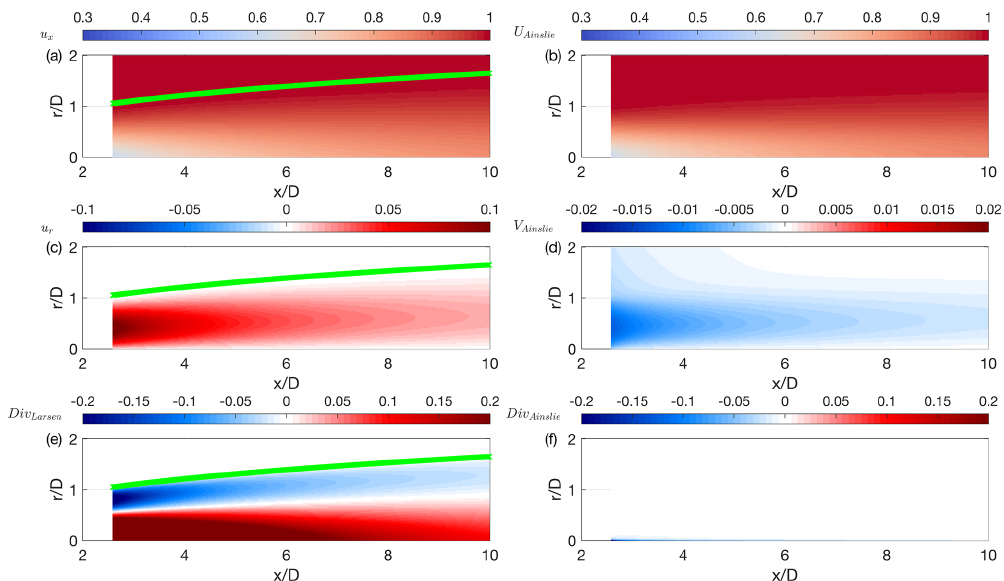
Figure B1. Assessment of the Larsen wake model (a, c, e) against the Ainslie wake model (b, d, f) : (a–b) streamwise velocity, (c–d) radial velocity, (e–f) residual of the mass conservation. The green lines represent the wake edges defined from the Larsen wake